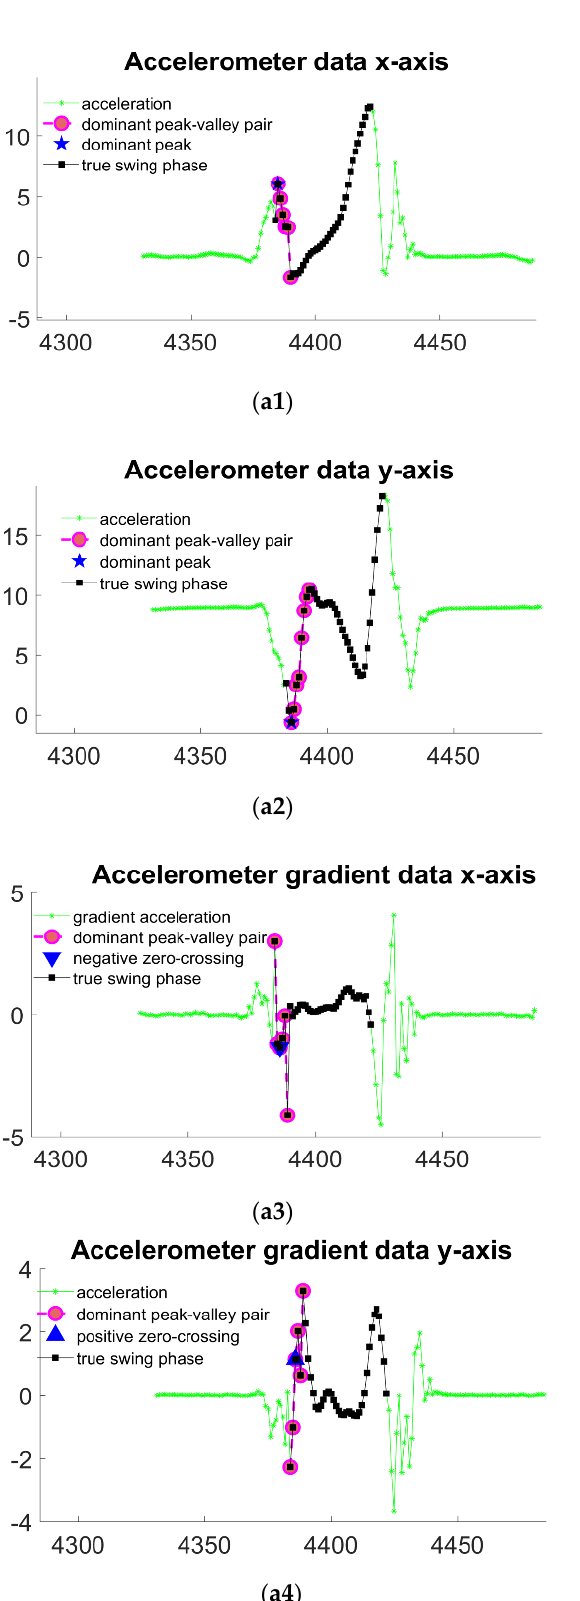
Figure 6. The detection of boundaries between push-off phases and swing phases are shown in sub- figures ( a1 , a2 , a3 , a4 ). The boundaries for dividing swing phases and heel-strike phases are shown in subfigures ( b1 , b2 , b3 , b4 ). Among all subfigures, ( a1 , b1 ) both use major peak-valley pairs in sagittal acceleration as reference information; ( a2 , b2 ) both use major peak-valley pairs in vertical accelera- tion as reference information; ( a3 , b3 ) show the utility of zero-crossings in sagittal acceleration data as reference information; ( a4 , b4 ) show the utility of zero-crossings in vertical acceleration data as reference information to recognize the gait